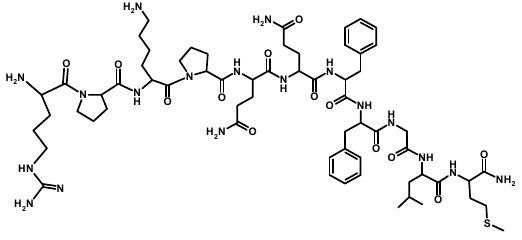
Figure 2. Structure of Substance P(1–11).